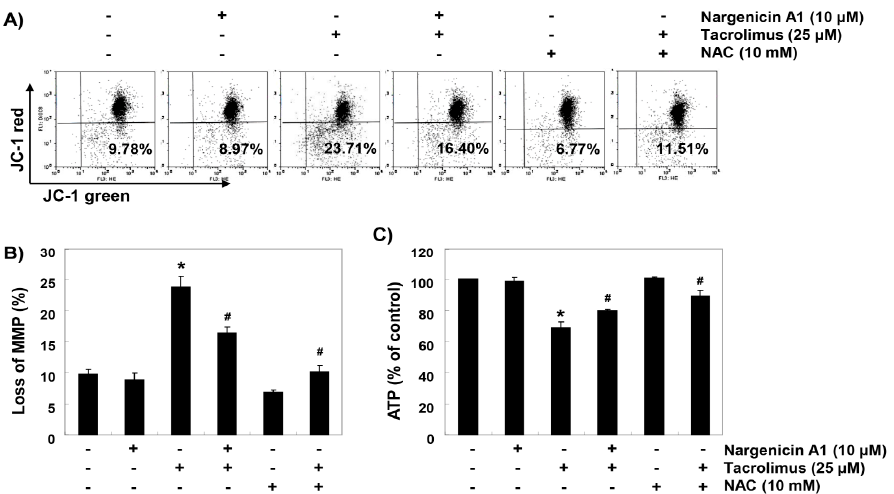
Figure 5. Attenuation of tacrolimus-induced mitochondrial dysfunction by nargenicin A1 in HINAE cells. Cells were pretreated with 10 µ M nargenicin A1 or 10 mM NAC for 1 h and then stimulated with or without 25 µ M tacrolimus for 24 h. ( A ) Cells were collected and incubated with 10 µ M JC-1, and mitochondrial membrane potential (MMP) values were determined by flow cytometry. ( B ) Results